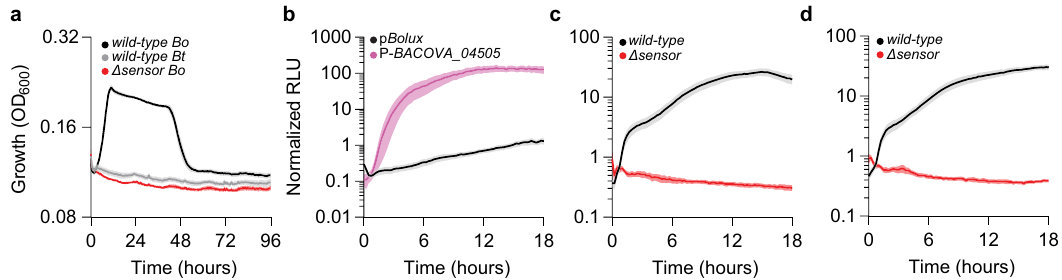
Fig. 5| Species-speci fi c responses enablePULreportersto distinguishbetween compositionally identical yet structurally distinct glycans. a Growth of wild-type Bt (gray) and Bo (black) or a strain lacking the Bo inulin sensor ( Δ BACOVA_04496 , red) were measured during anaerobic culture in minimal media containing inulin as a sole carbon source. b Relative luminescence from wild-type Bo harboring p Bolux (black)or aplasmidincluding the promoter region preceding the inulin-inducible susC gene (P- BACOVA_04505 , pink) were measured following the introductionofinulin as the sole carbonsource and normalized by the relative